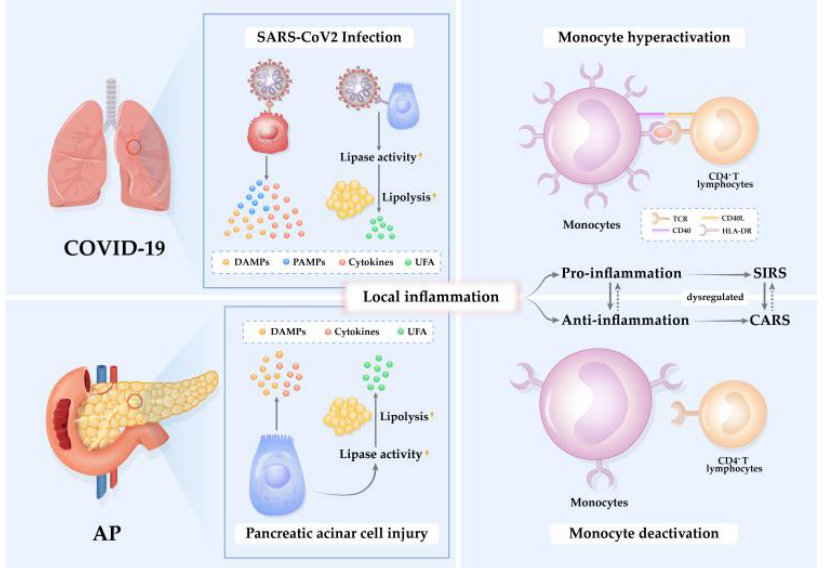
Figure 1. Pathogenesis of inflammation in AP and COVID-19. Acute pathological insults of SARS-CoV-2 infection and pancreatic acinar cell injury elicit local inflammation mediated by cytokines, unsaturated fatty acids (UFAs), damage-associated molecular patterns (DAMPs), and/or pathogen-associated molecular patterns (PAMPs). The pro-inflammatory reaction induces an anti-inflammatory response to restrict inflammation. When the pro-/anti-inflammation is unbalanced and dysregulated, systemic inflammatory response syndrome (SIRS) or compensatory anti-inflammatory response syndrome (CARS) occurs. During SIRS, monocytes are hyperactivated in response to high levels of pro-inflammatory cytokines and chemokines. In contrast, during CARS, monocytes are deactivated, exhibit reduced mHLA-DR expression, and are incapable of presenting antigens to activate CD4 + T lymphocytes.